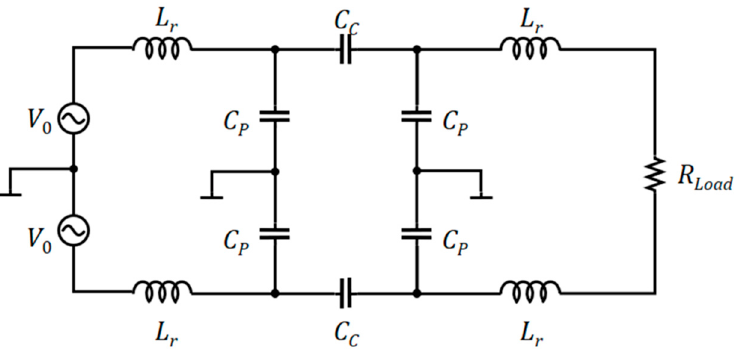
Figure 3. Circuit model for S-CPT-coupling-capacitance analysis.